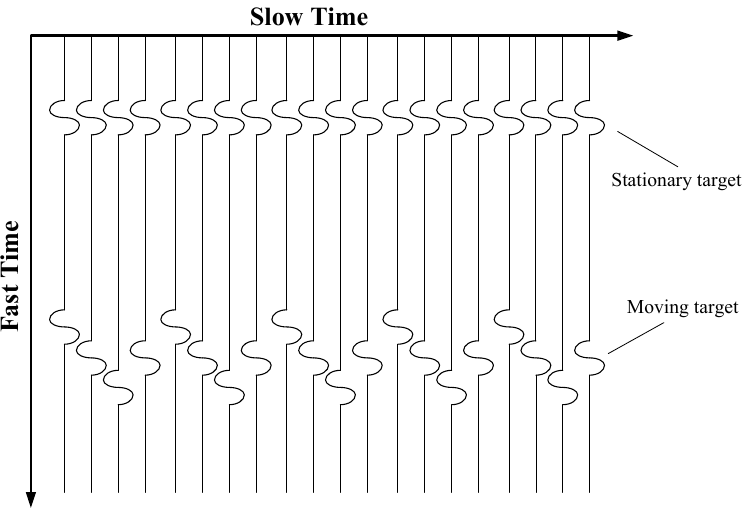
Figure 1. Schematic diagram of vital signs signals detection effect. Sampling the radar signals’ waveform at continuous discrete time series when the pulse accumulation time t = mT s ( m = 1, 2, . . . , M ), the received echo signals observed for a long time are: